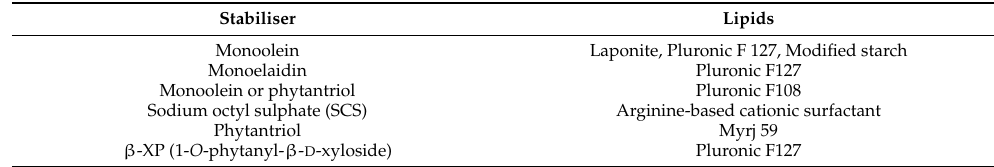
Table 4. Lipids and stabilizing agents used in cubosome preparation